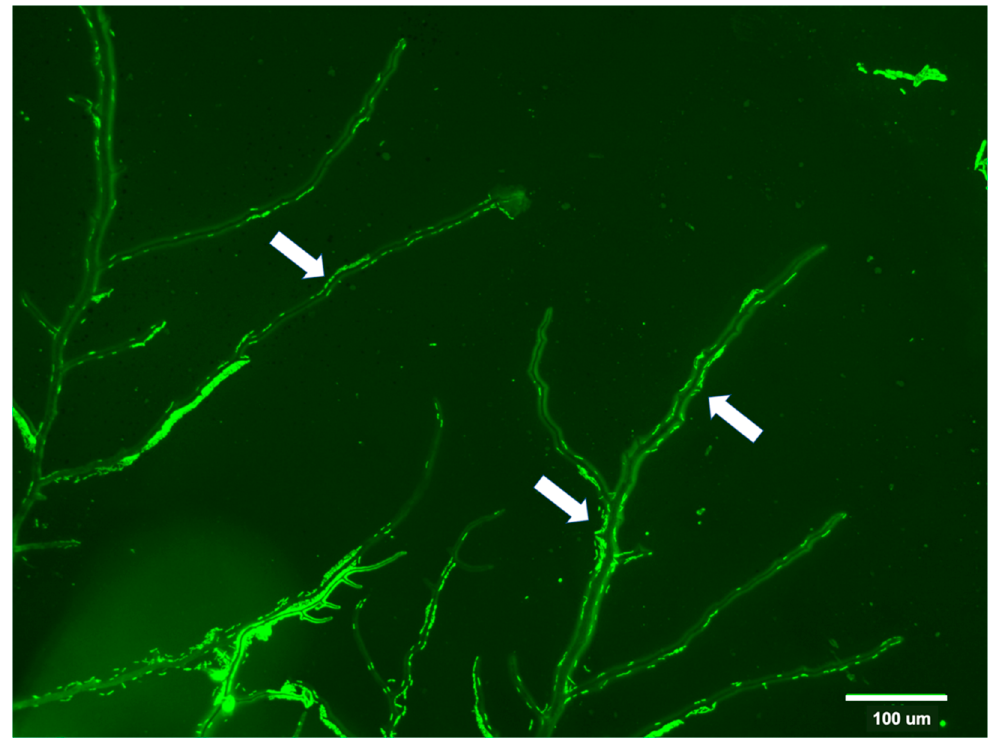
Table 5. Screening of representative plant growth ‒ promoting traits in selected bacterial isolates dis- persed along of fungal hyphae. Isolate